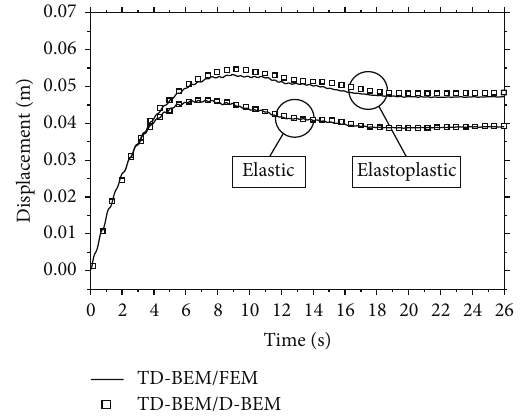
Figure 12: Radial displacement considering coupled TD-BEM/D- BEM and coupled TD-BEM/FEM analyses: linear and nonlinear results at point